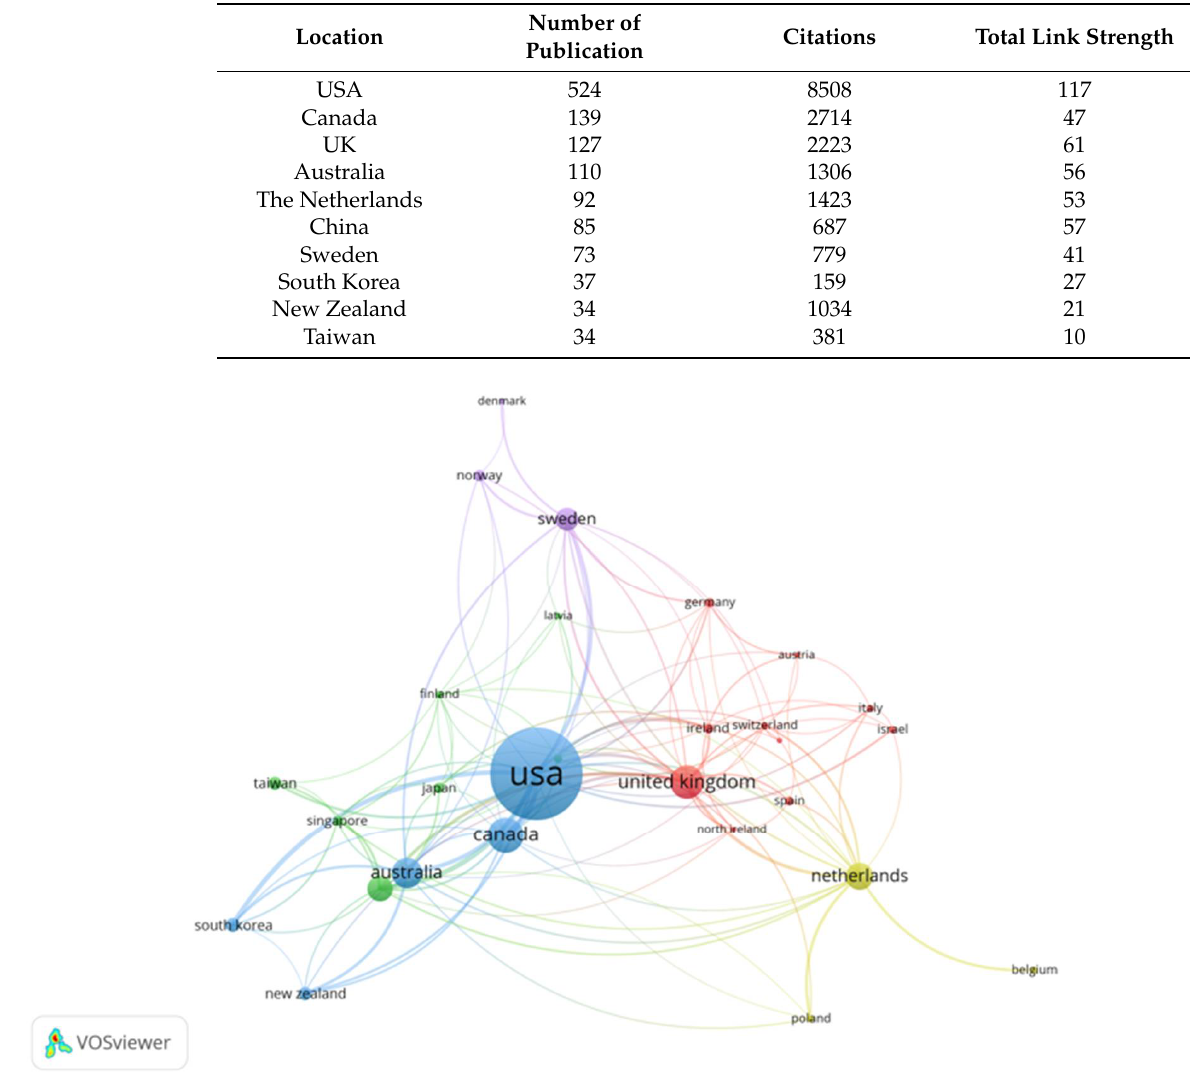
Figure 5. Network visualization of